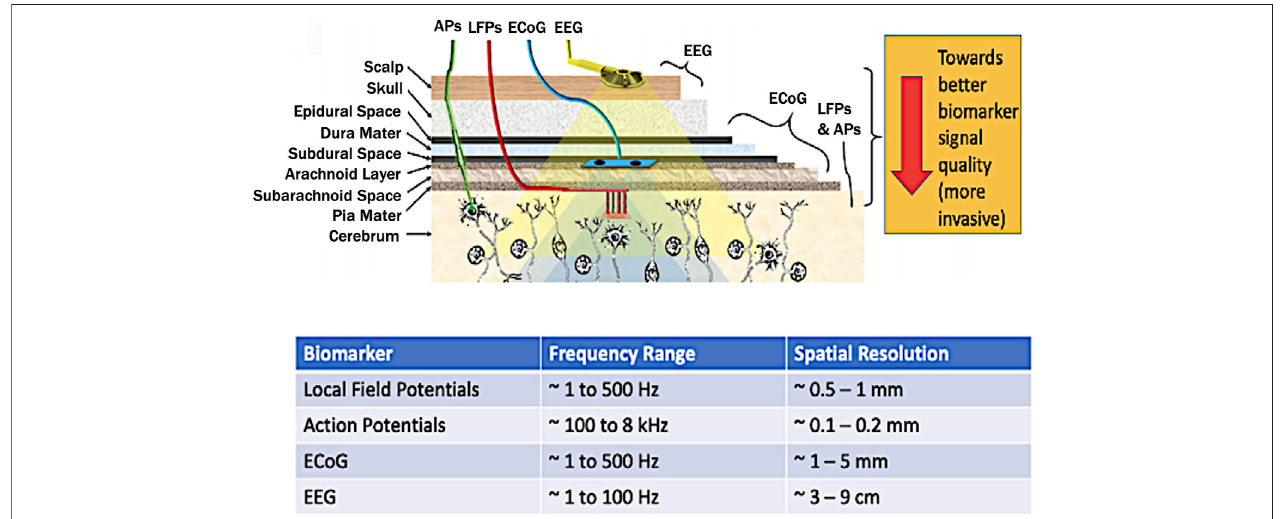
FIGURE 4 | Brain biomarkers for closed-loop DBS stimuli (top fi gure adapted from Parastarfeizabadi and Kouzani, 2017). Abbreviations: LFP – local fi eld potential; AP – Action Potential; ECOG – Electrocorticography; EEG - Electroencephalography.